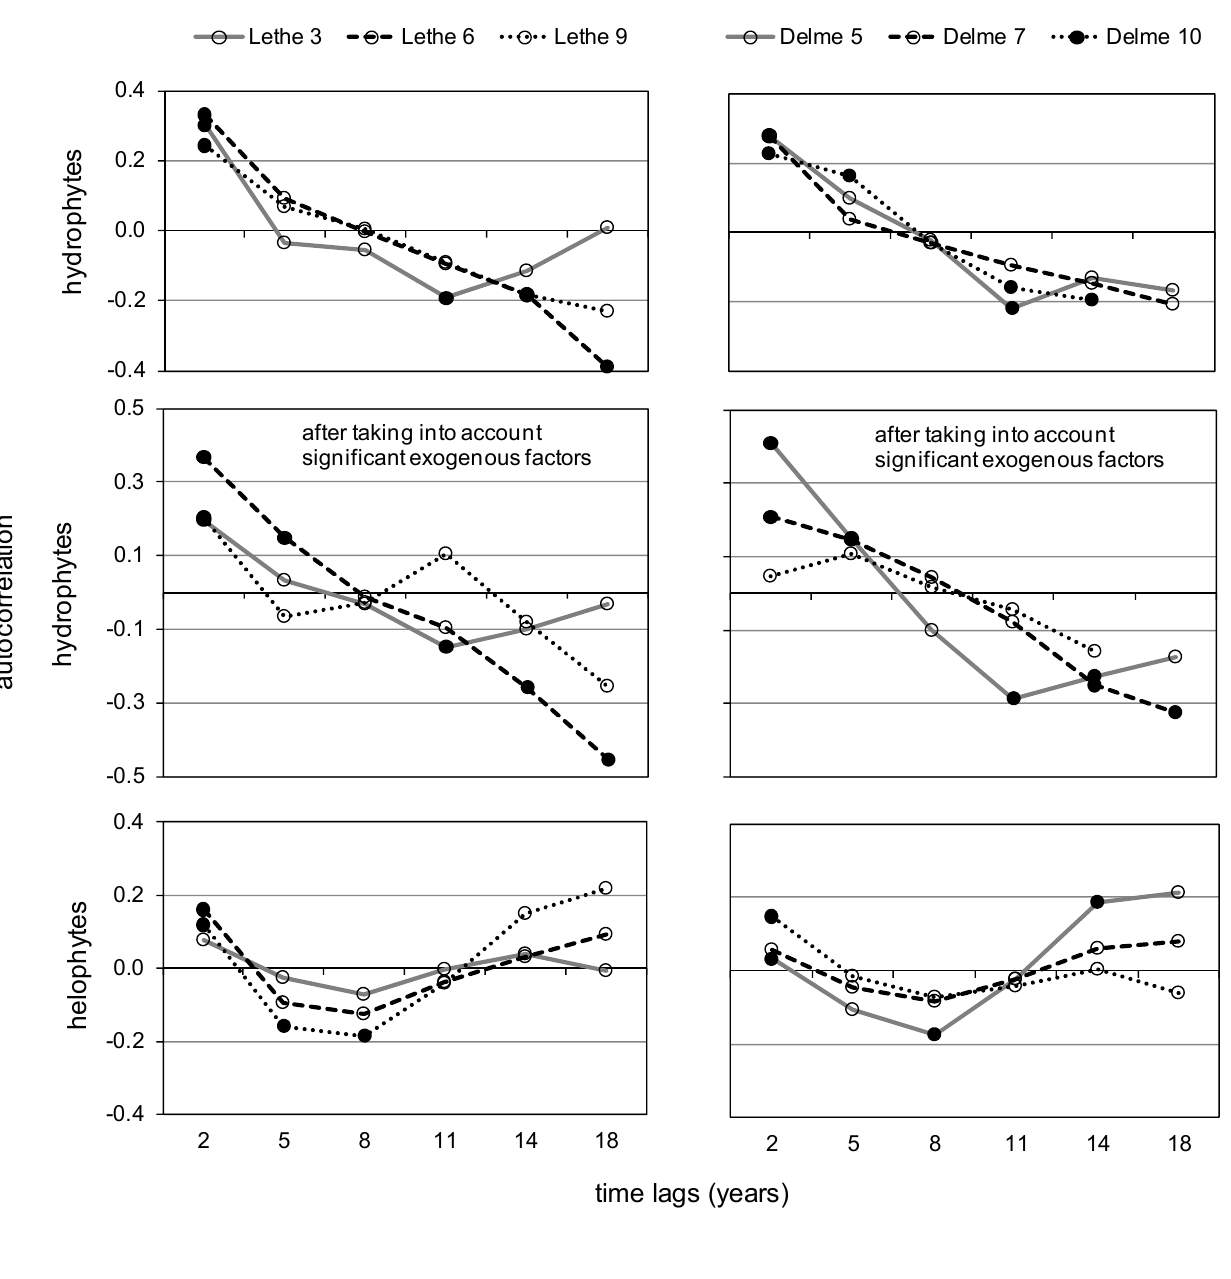
Figure 6. Temporal autocorrelograms of plant species composition at yearly time steps at six sites from the rivers Lethe and Delme (Lower Saxony, Germany). Note the similarities and differences in patterns within and between hydrophytes and helophytes. Significant tests are indicated by a filled symbol (after progressive Bonferroni correction of α = 0.05/k for the kth distance class). Mantel statistics range from − 1 to 1. Positive Mantel statistics represent positive autocorrelation. Number of comparisons per class ranged from 21 to 57; except for D10 (12–48 comparisons) from which the analyses were based on the first 18 years of the time series, there being no species in two of the last three years (1996,